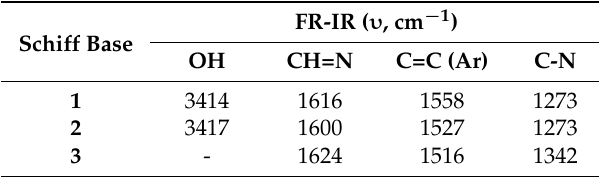
Table 2. Some FT-IR spectral data for Schiff bases 1 − 3 .